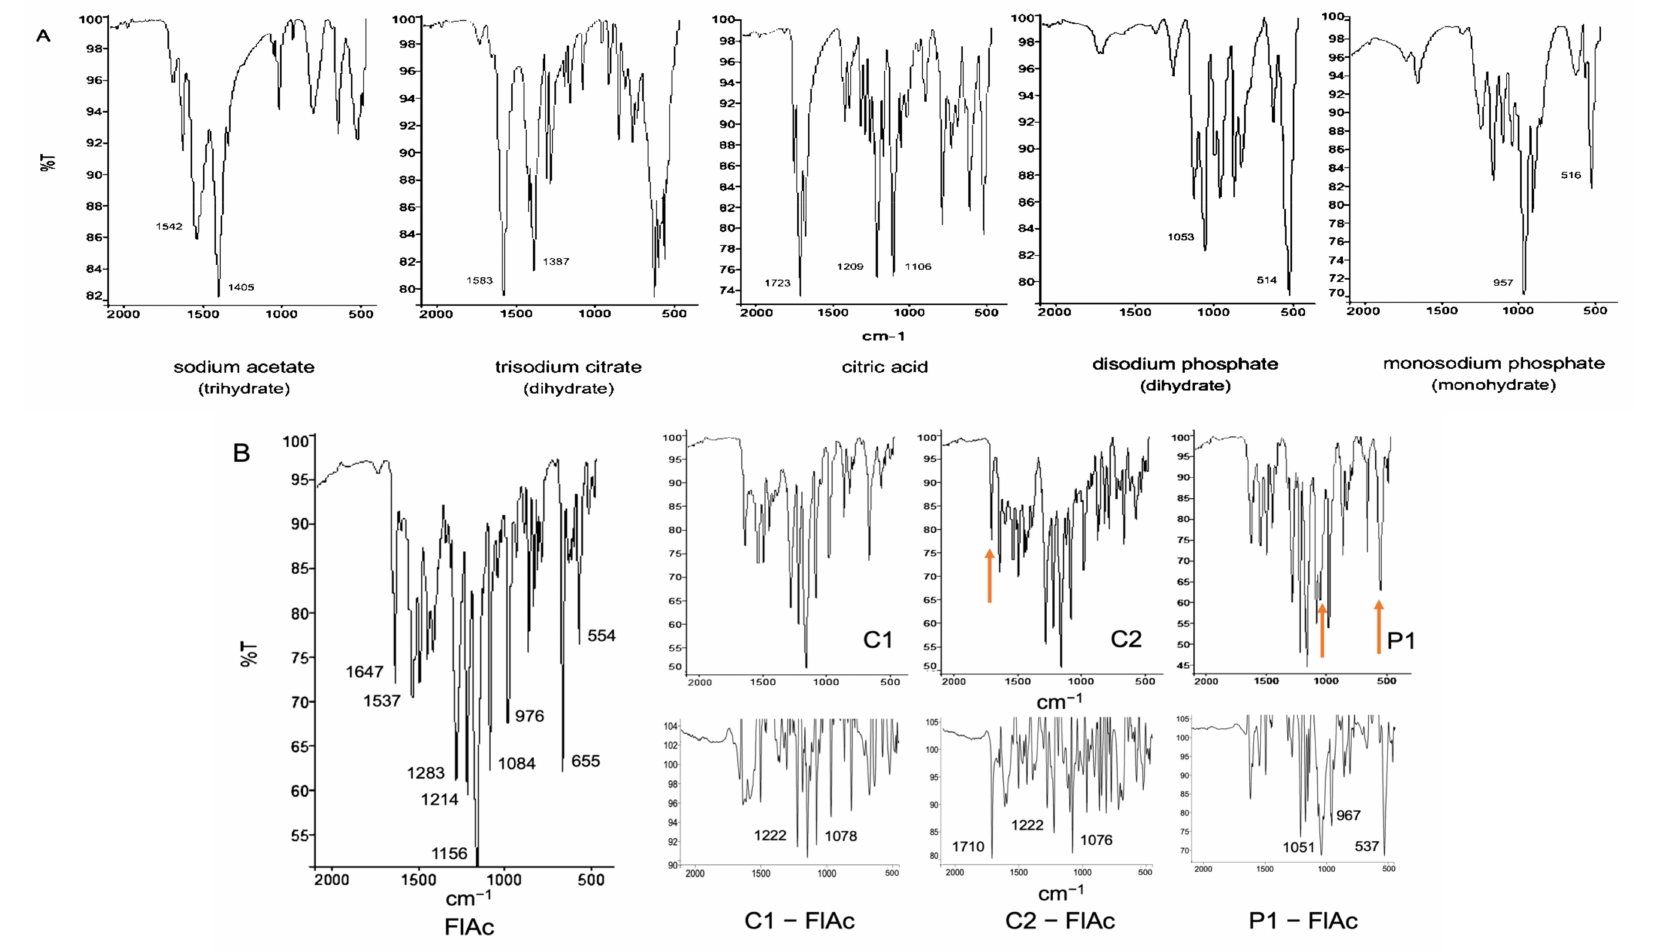
Figure 3. ( A ) Infrared spectra of citric acid and various sodium salts containing anions of interest; ( B ) infrared spectra and comparisons of flecainide acetate (FlAc) and its different solid forms isolated from buffered solutions (C1 obtained from F5; C2 from F6; P1 from